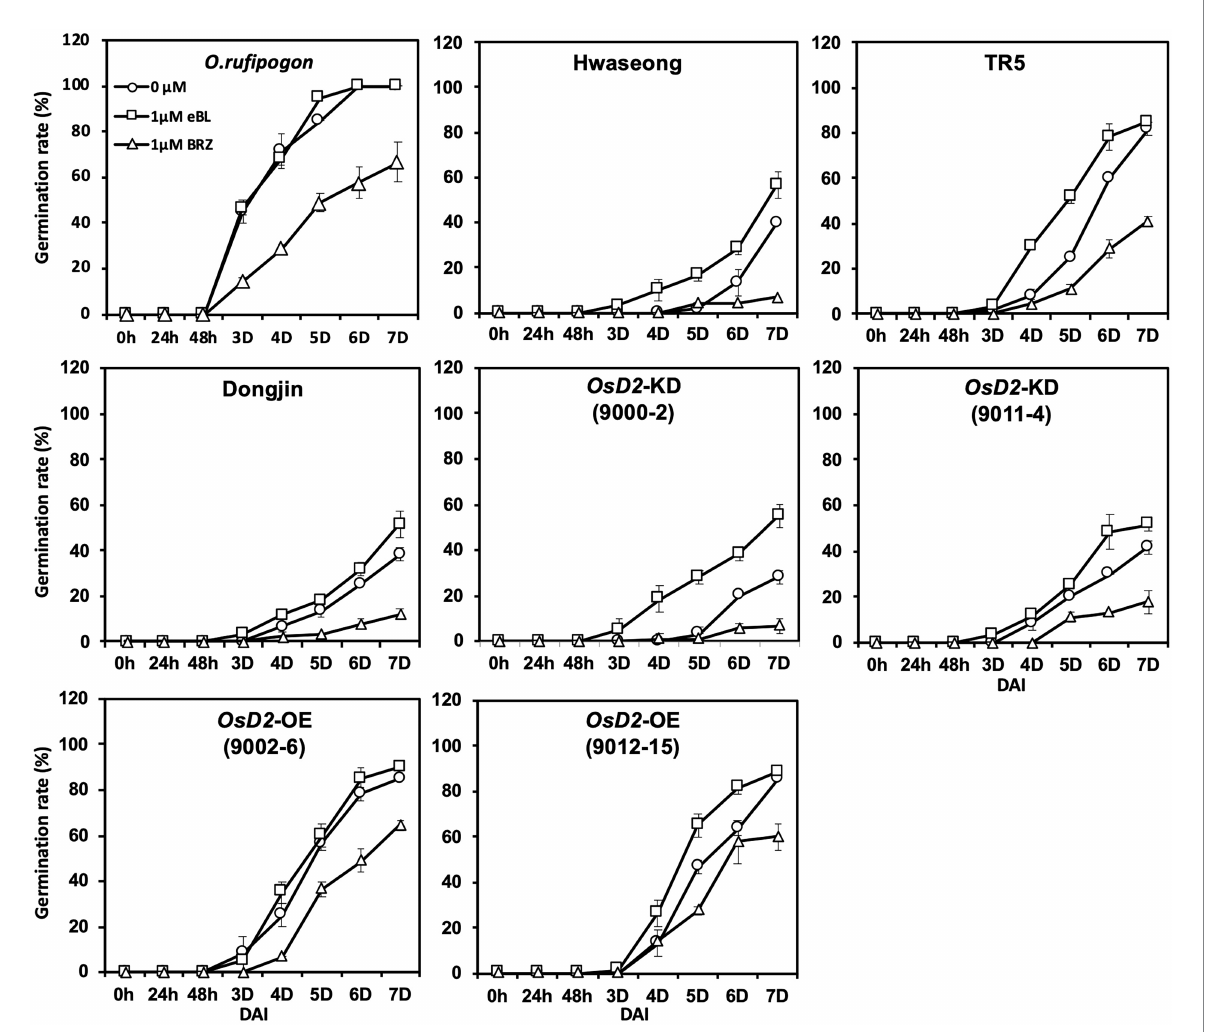
FIGURE 6 Comparison of the low-temperature germinability of eight plant materials under the exogenous brassinosteroid and brassinosteroid biosynthesis inhibitor treatment. Twenty-five seeds were incubated at 13 ° C with control (circle), 1 μ M 24-epi-brassinolide (eBL; square), and 1 μ M brassinazole (BRZ; triangle) for 7 days. Data are presented as mean ± SD ( n = 3). DAI, days after